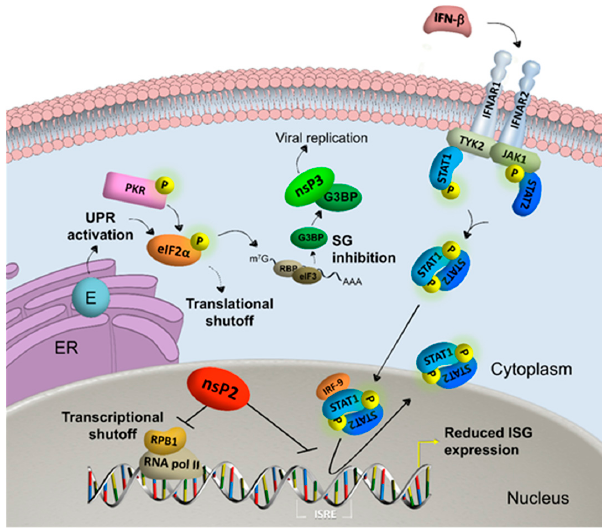
Figure 2. Alphavirus nonstructural protein 2 (nsP2) reduces interferon (IFN)-stimulated gene (ISG) expression by inducing transcriptional shutoff via RNA polymerase II (RNA pol II)-mediated host cell transcription by degradation of RNA polymerase subunit RPB1 and blocking the IFN-induced janus kinase-signal transducer and activator of transcription (JAK-STAT) pathway. Viral envelope (E) proteins activate the unfolded protein response (UPR) in the endoplasmic reticulum (ER) and together with kinases such as protein kinase R (PKR) phosphorylate eukaryotic translation initiation factor 2 α (eIF2 α ). The subsequent induction of stress granules (SG) is inhibited by viral nonstructural protein 3 (nsP3), which sequesters Ras GTPase-activating protein-binding protein (G3BP) into viral granules that favor viral replication. General translational shutoff is additionally induced by alphavirus infection independent of eIF2 α phosphorylation. Abbreviations: interferon- α / β receptor (IFNAR); tyrosine kinase (TYK); interferon regulatory factor (IRF); interferon stimulated response element